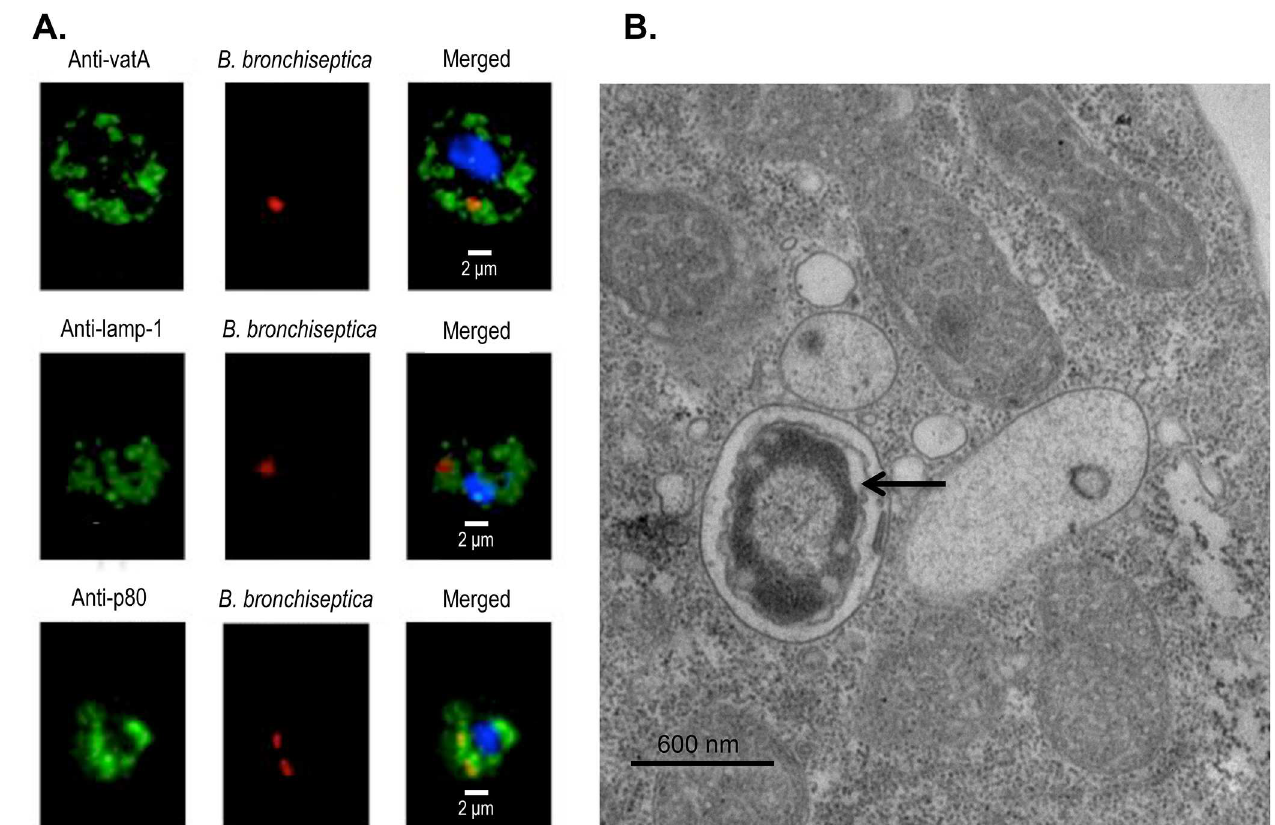
Fig 2. Visualization of B . bronchiseptica within D . discoideum . ( A) Fluorescent confocalimagingof B . bronchiseptica within D . discoideum . D . discoideum were exposedto B . bronchiseptica RB50 pLC018(mCherry, red) for 1 h at a multiplicityof infection (MOI) of 100 prior to 1 h gentamicintreatment. D . discoideum were then fixed in 4% paraformaldehyde and permeabilizedwith 0.1% saponinprior to incubationwith the followingprimary antibodies: mouse monoclonal anti-vatA, rat monoclonal anti-lamp-1,and mouse monoclonal anti-p80. Secondary antibodies, specificallygoat anti-mouse and goat anti-rat, were conjugatedto either fluoresceinor a green fluorescent dye (green). D . discoideum were also stainedwith DAPI for visualizationof nuclei(blue). Z-stacks were captured at 60 × magnification and zoomed to 300%. Individualpanelsand mergedfluorescent images are displayed. (B) Electron microscopy images of intracellular B . bronchiseptica within D . discoideum . D . discoideum were exposedto B . bronchiseptica RB50 for 1 h at a MOI of 100 prior to 1 h gentamicintreatment. Followingexposureand gentamicintreatment, D . discoideum harboringintracellularbacteria were fixed for 1 h in 2% glutaraldehyde and then processed for transmissionelectron microscopy. The image shows a singleintracellularbacterium(arrow) within D . discoideum .